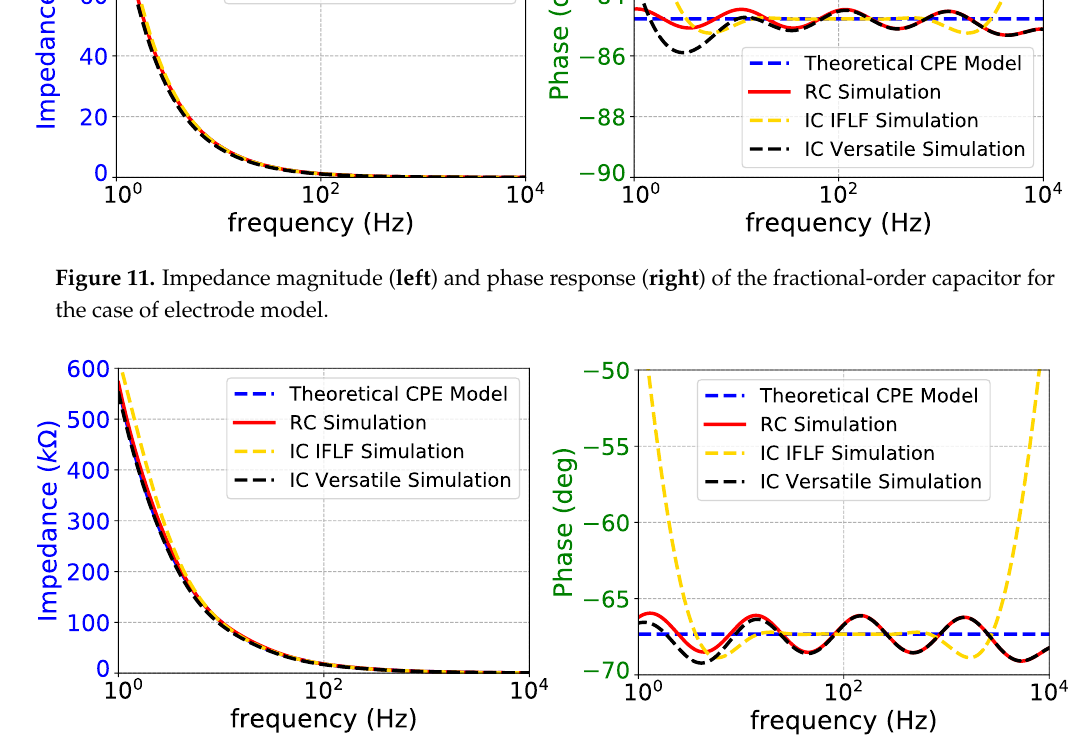
Figure 12. Impedance magnitude ( left ) and phase response ( right ) of the fractional-order capacitor for the case of skin model.